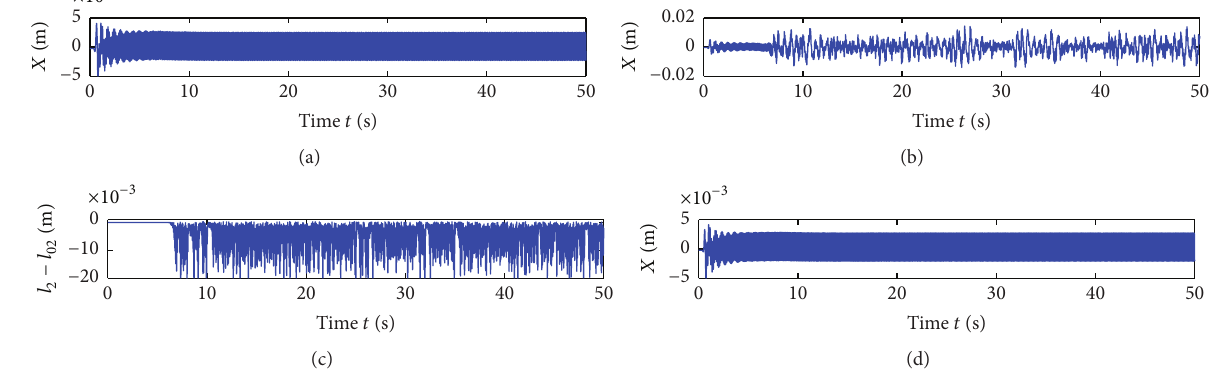
Figure 5: 𝑋 displacement of the core assembly when Ω = 13.5 Hz, 𝐹 pre = 100 N (a); Ω = 14.5 Hz, 𝐹 pre = 100 N (b); elongations of the second suspension rod when Ω = 14.5 Hz, 𝐹 pre = 100 N (c); and 𝑋 displacement of the core assembly when Ω = 16 Hz, 𝐹 pre = 200 N